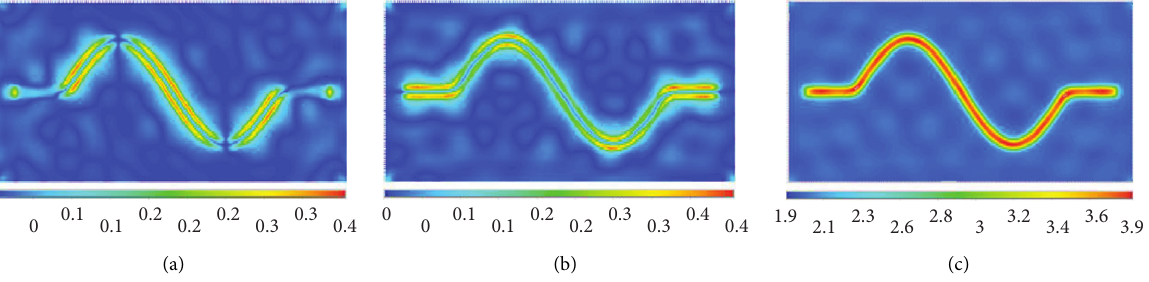
� 500m/s, and NR � 2). Top view displacement cloud view (a) u s